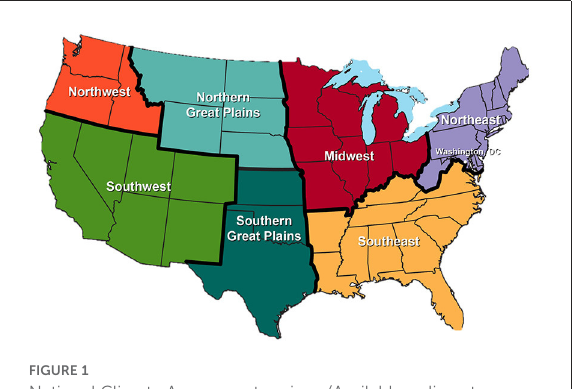
FIGURE1 National Climate Assessment regions (Available online at: https://www.c2es.org/content/national-climate-assessment/). SE, southeast, NE, northeast, MW, Midwest, SGP, southern great plains, SW, southwest, NGP, northern great plains, NW,